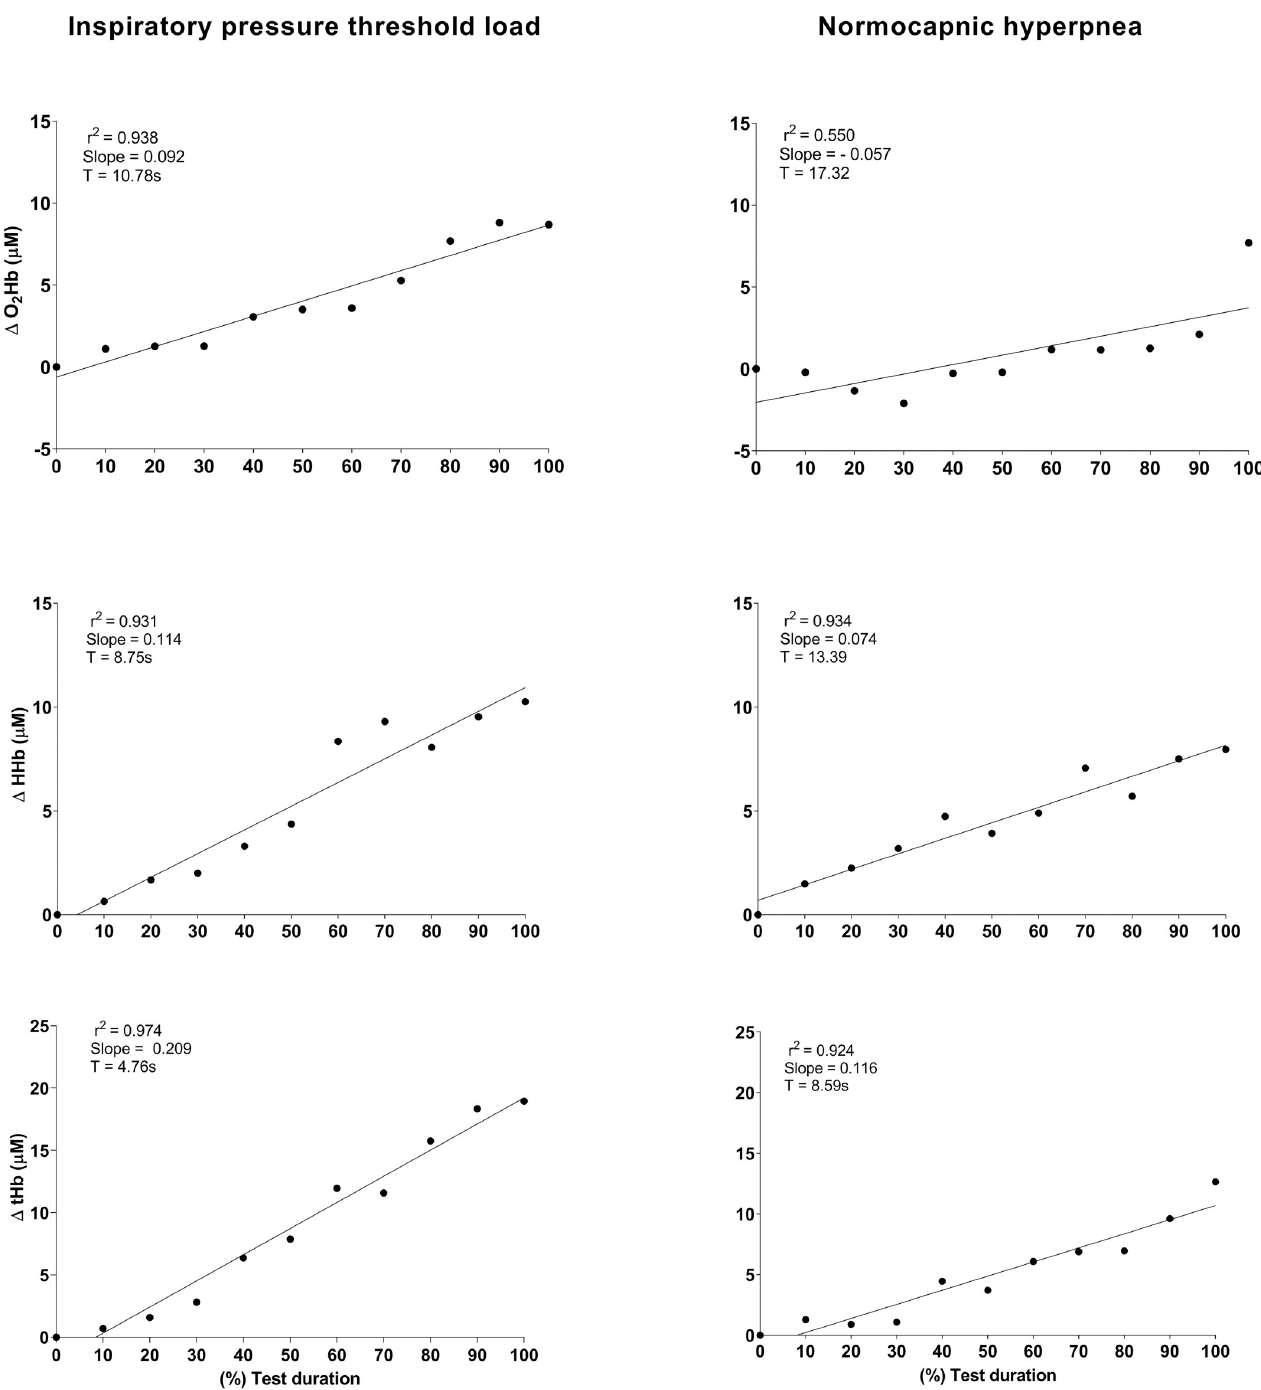
Fig 3. Time courses of tissue oxygenation variables of sternocleidomastoid muscle during endurance test. Each point during the test is the average of every 10% of test duration until time limit. Abbreviations: O2Hb = Oxyhemoglobin; HHb: deoxyhemoglobin; tHb: total hemoglobin. %: percentage.